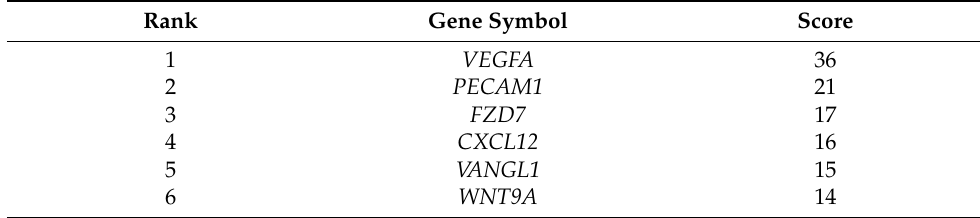
Table 1. Ranking of the top 10 hub